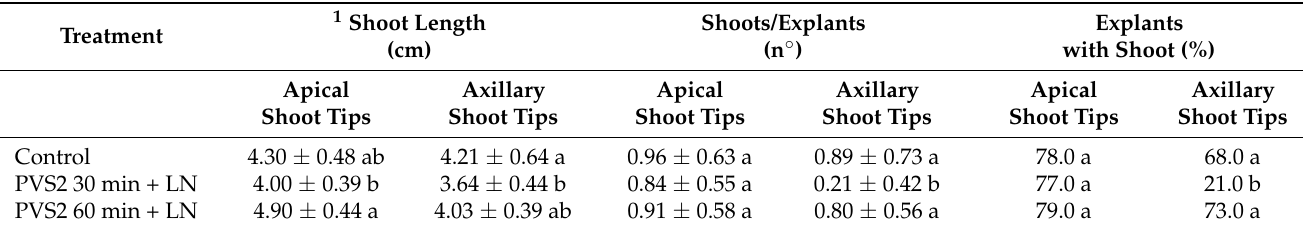
Table 2. First subculture after droplet-vitrification procedure: morphological parameters of S. rebaudiana shoots, from control and from cryopreserved apical shoot tips and axillary shoot tips. (Means ± SD).